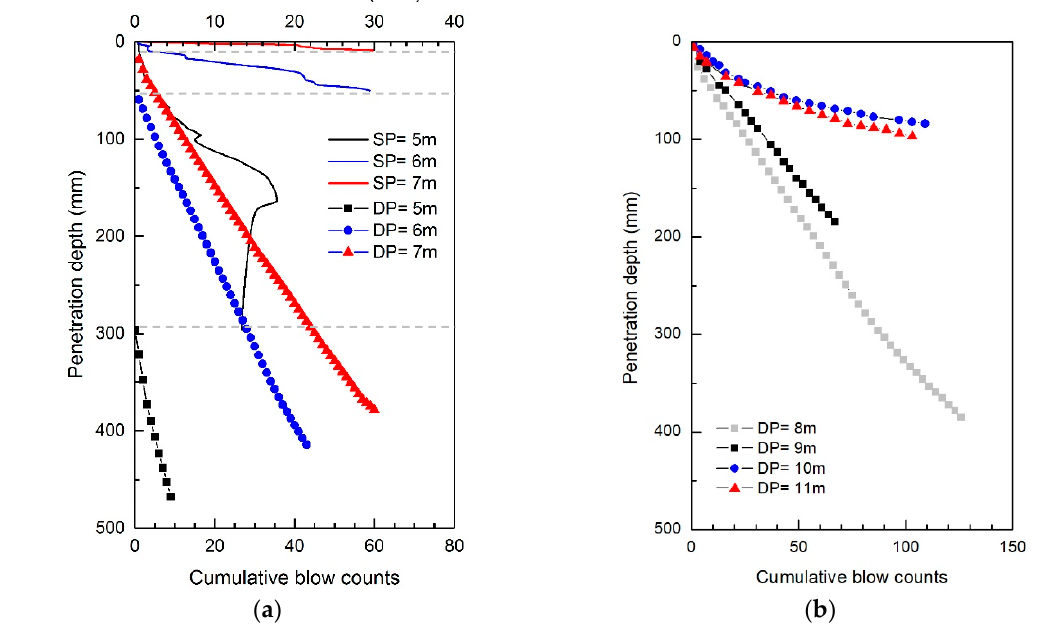
Figure 7. Profiles of static cone resistances and cumulative blow counts obtained from ICP at site B: ( a ) 5–7 m; ( b ) 8–11 m. SP and DP denote the static and dynamic cone penetration tests, respectively. Note that the data points at the depths of 8–11 m indicate penetration depths at every three blows.